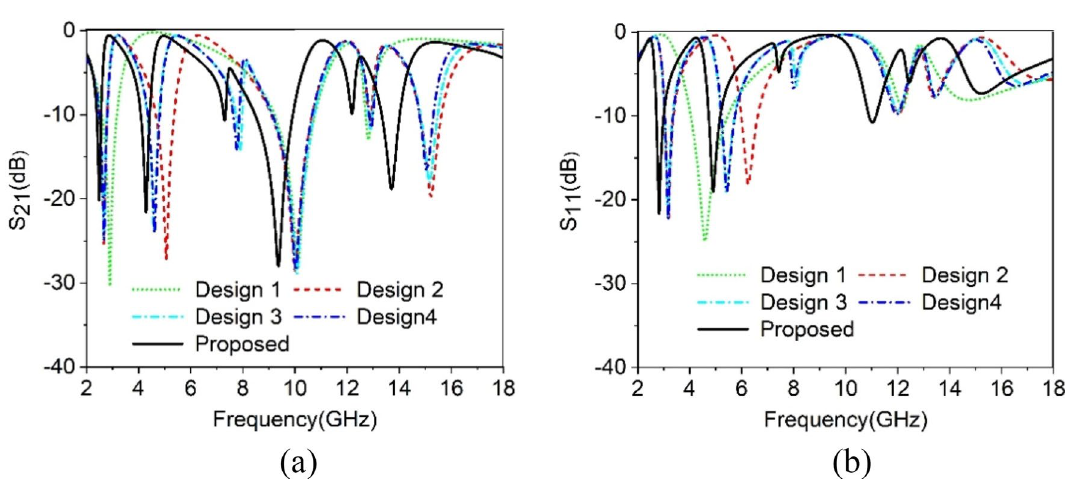
Figure 3. MTM unit cell design methodology. (CST STUDIO SUITE 2019, https:// www. 3ds. com/ produ cts- servi ces/ simul ia/ produ cts/ cst- studio- suite) 28 .